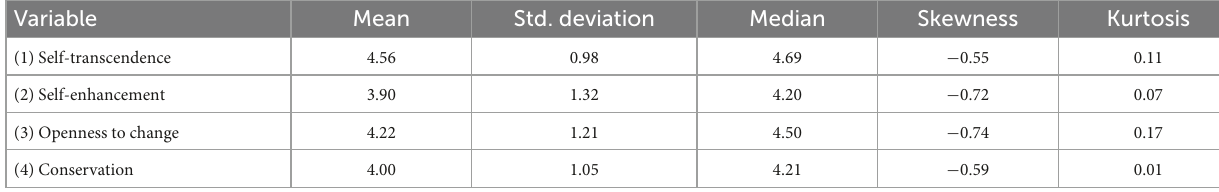
TABLE 1 Descriptive statistics for study variables a . Variable